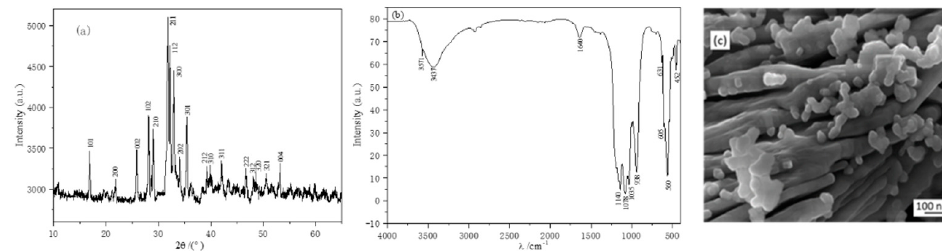
Figure 1. The characterization of HAP: ( a ) XRD; ( b ) FTIR; ( c ) SEM. According to the highest characteristic peak for HAP {211} at 2 θ = 31 ◦ , the calculated interplanar spacing is 14.6 nm. Figure 1b shows the FTIR spectra of HAP in the range of 4000–400 cm − 1 . Bands related to the water molecules of hydration at about 1640 cm − 1 ( δ OH of hydration water molecules) and at approximately 3437 cm − 1 (mOH of hydration water molecules) were also present. The recorded symmetric P–O stretching vibration of the PO 43 − band at 938 cm − 1 , the triply degenerated bending vibrations at 605 cm − 1 , as well as the band at 452 cm − 1 , are attributed to the HAP [25]. The adsorption bands at 1140 cm − 1 can be assigned to the P–O–H deformation modes, which indicate the presence of the HPO 42 − ionic group in calcium deficient HAP. The characteristic adsorption bands at 3571 and 631 cm − 1 that correspond, respectively, to the stretching vibration and bending deformation modes of the lattice OH − ions, indicate the formation of the crystalline HAP phase. The characteristic bands for PO 43 − also appear at 1078, 1035, 605, 560 and 452 cm − 1 . The SEM micrograph of HAP consisted of a lamellar structure and some agglomerated